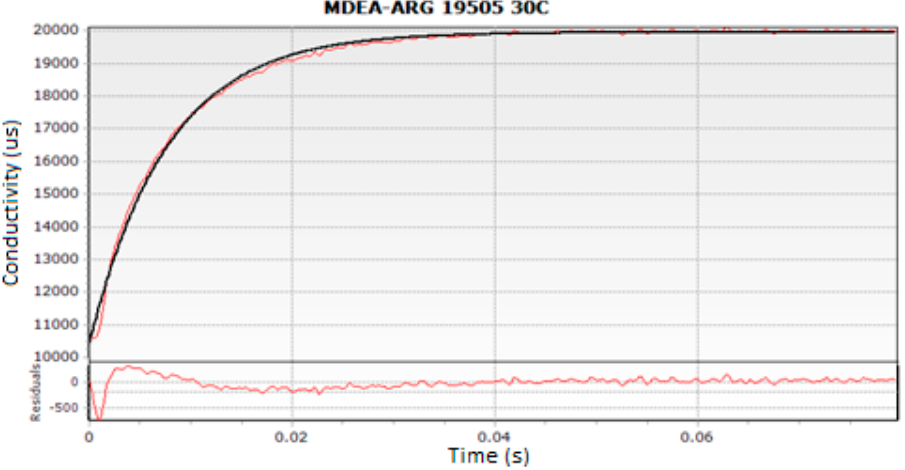
Figure 3. A Schematic Diagram of the Stopped-Flow Apparatus.